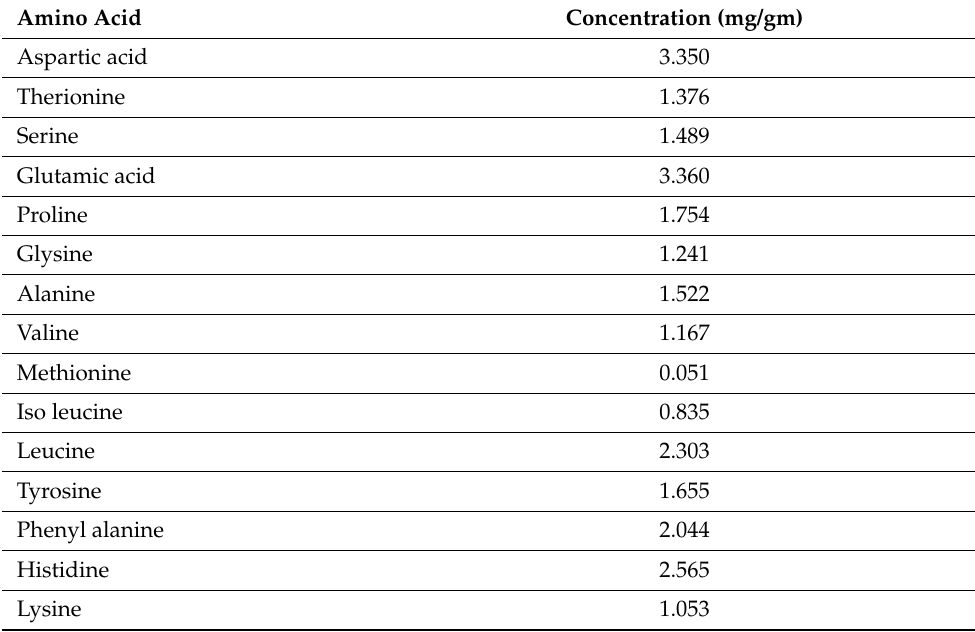
Table 1. Amino acid contents of Eobania vermiculata